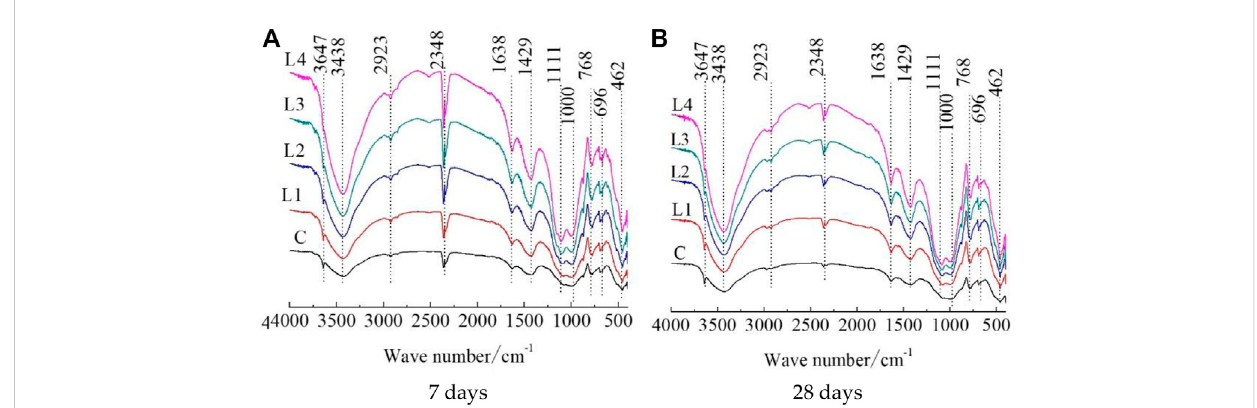
FIGURE 5 Spectral characteristics of cement – lithium slag paste.